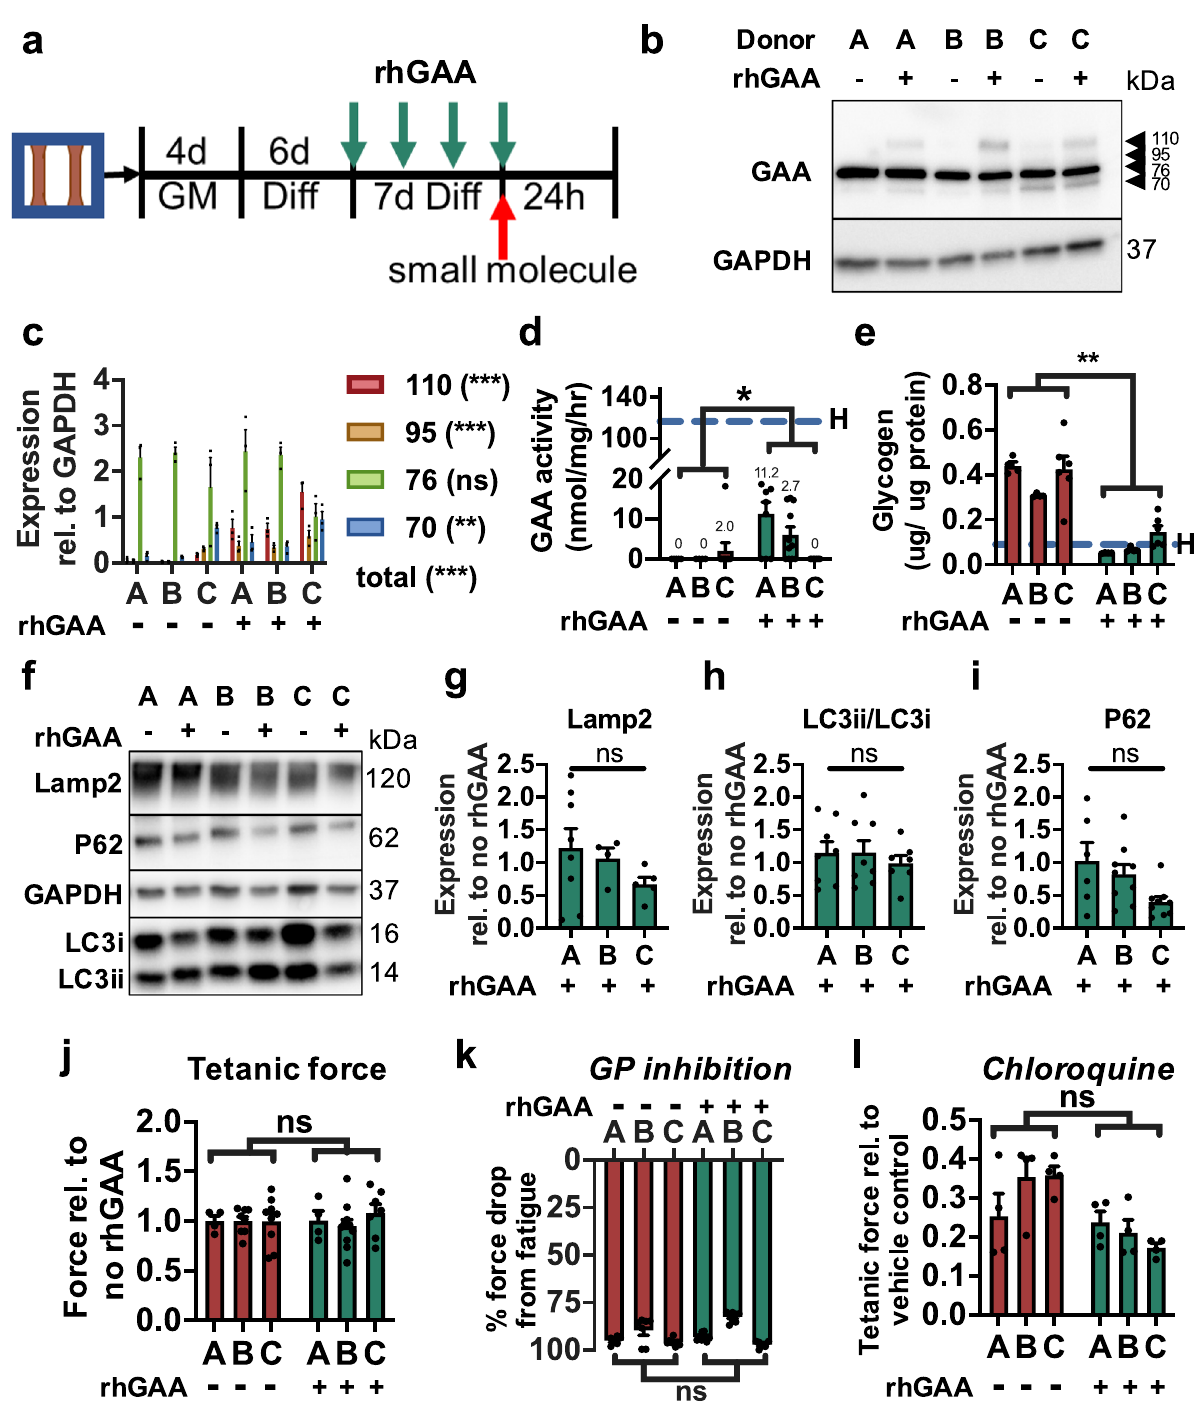
Fig. 4 Response of IOPD myobundles to rhGAA treatment. a Schematics depicting protocol for rhGAA treatment of IO myobundles. b , c , Representative western blot of GAA isoforms in rhGAA treated ( + ) and untreated ( − ) myobundles from 3 IOPD patients (A, B, C) ( b ) and quanti fi cation of isoform expression relative to GAPDH ( c , n = 3 myobundles per group). d , e GAA activity ( d , n = 4 – 11 myobundles per group) and glycogen content ( e , n = 4 – 6 myobundles per group) in IO myobundles after 1 week of rhGAA or no treatment. Dashed H-line denotes mean value across all healthy donors. f – i Representative western blot ( f ) and quanti fi cation of g Lamp2 expression, h LC3-II/LC3-I expression ratio, and i p62 expression ( n = 4 – 9 myobundles per group) in IO myobundles after 1 week of rhGAA or no treatment. j Tetanic force of IO myobundles after 1 week of rhGAA treatment shown relative to no treatment ( n = 4 – 11 myobundles per group). k Percent force decline at the end of fatigue stimulation after 24 h of GPi exposure following 1-week rhGAA treatment or no treatment ( n = 6 – 8 myobundles per group). l Tetanic force after 24 h of chloroquine exposure following 1-week rhGAA treatment or no treatment, shown relative to vehicle control ( n = 4 myobundles per group). Data: mean ± SEM. * p < 0.05; * p < 0.01; ns, not signi fi cant between rhGAA- treated and untreated